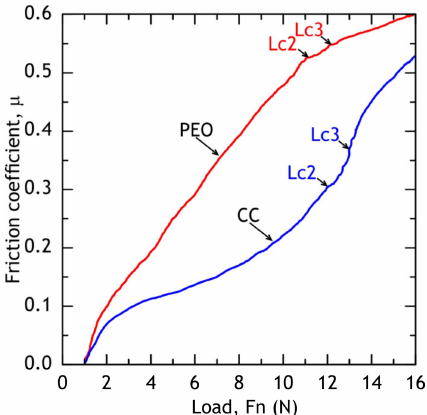
Figure 10. Evolution of friction coe ffi cient during the scratch test of PEO and composite.